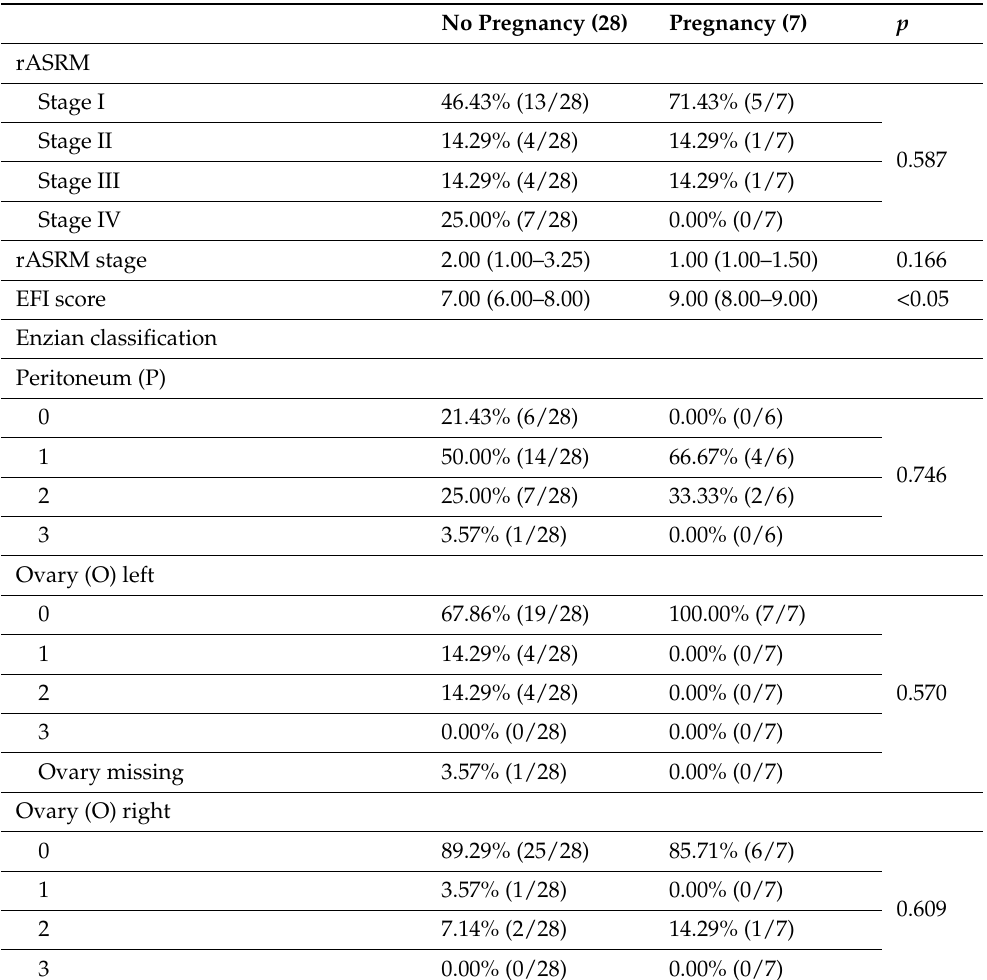
Table 3. Spontaneous pregnancies: score subdivided in accordance with the pregnancy